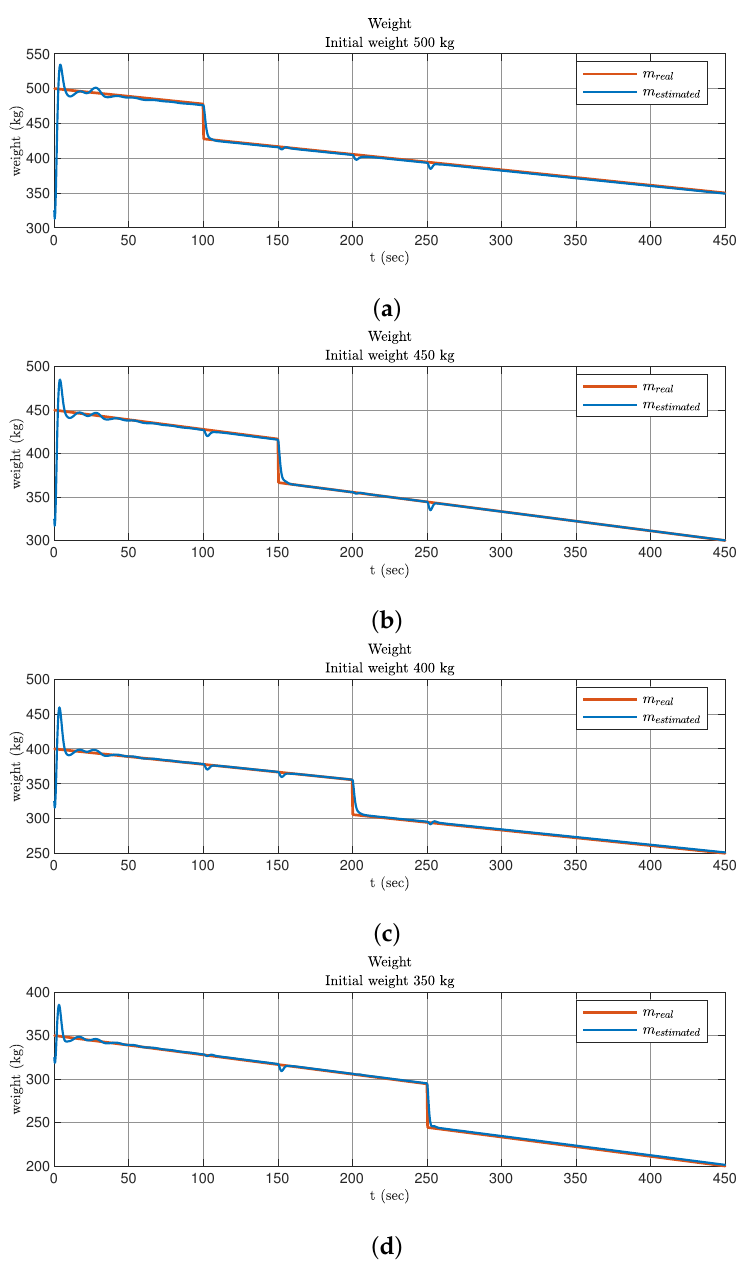
Figure 7. Estimated mass values when controlling a group of UAVs of variable mass with initial mass values of 500 kg ( a ), 450 kg ( b ), 400 kg ( c ), and 350 kg ( d